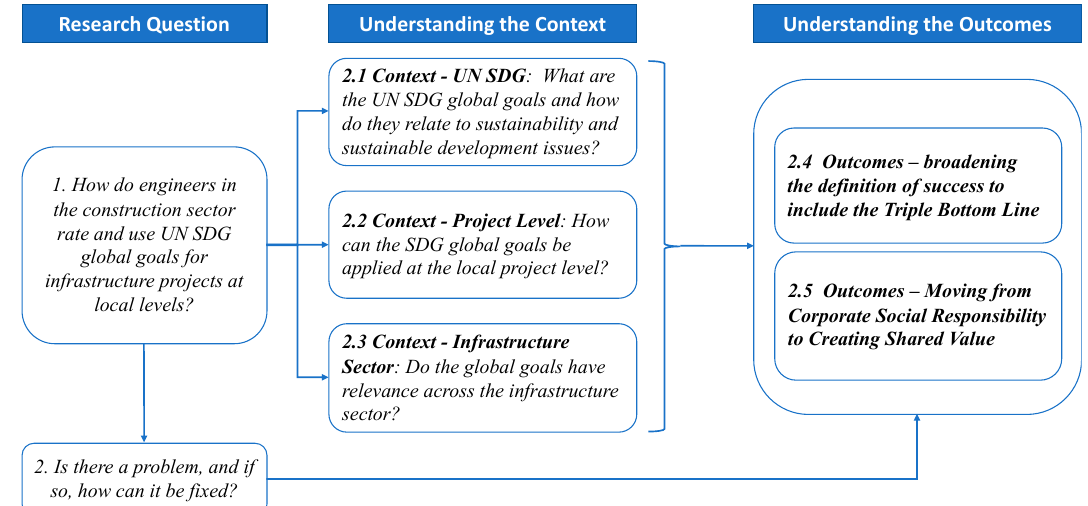
Figure 1. The logic chain illustrating the relationship between the research question and the contextual and outcome thematics.